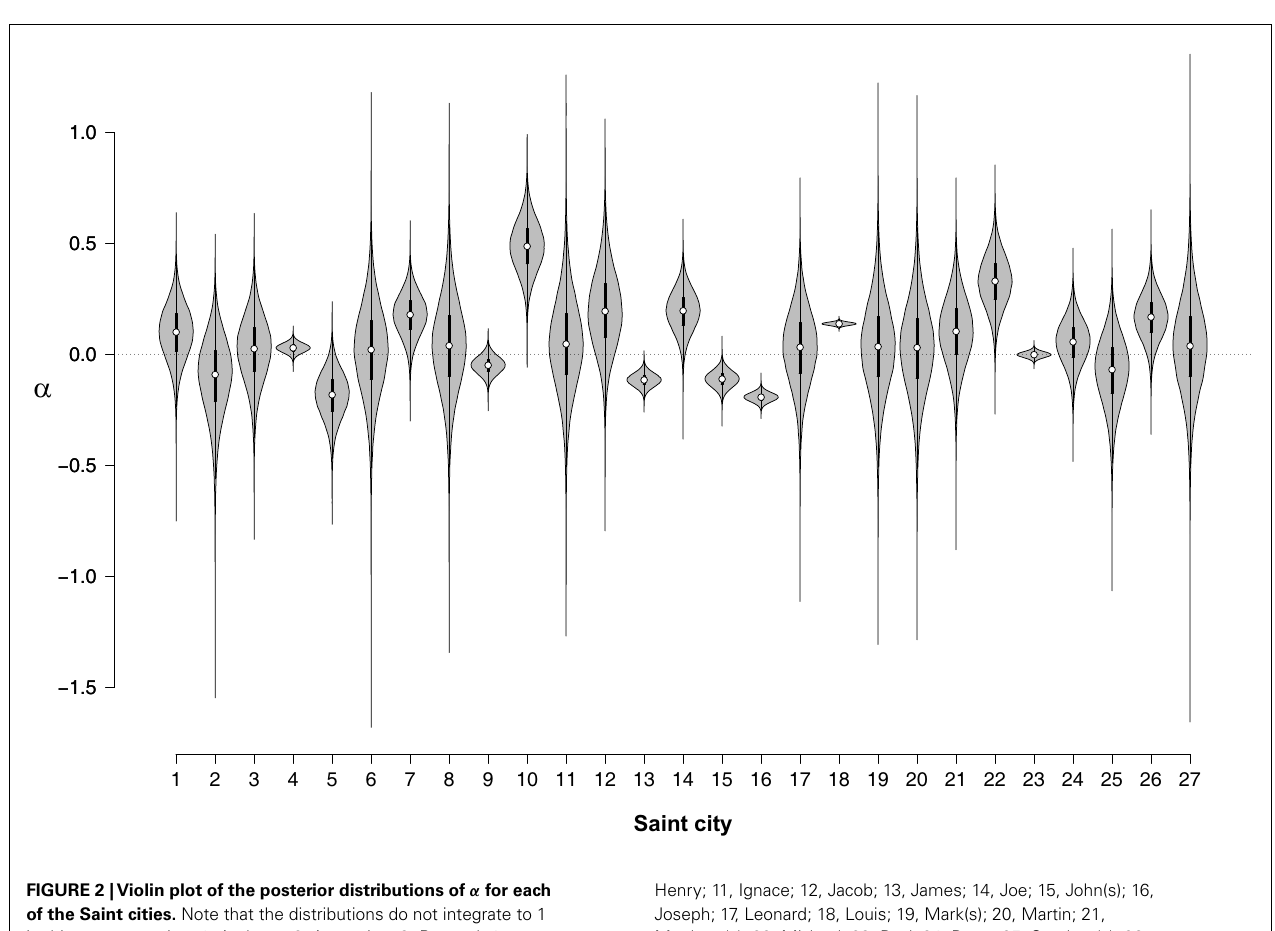
FIGURE 2 |Violin plot of the posterior distributions of α for each of the Saint cities. Note that the distributions do not integrate to 1 in this representation. 1, Anthony; 2, Augustine; 3, Bernard; 4, Charles; 5, David(s); 6, Elmo; 7, Francis; 8, Gabriel; 9, George;